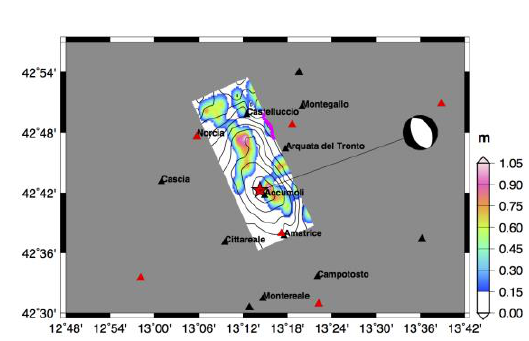
Figure 1: Inverted rupture model [Cirella& Pi- atanesi, 2016] projected on the Earth surface with villages up to 20 km distant from the nucleation . Colors on the fault plane indicate the slip distribu- tion; black contours represent the position of the propagating rupture at 1 s interval. Violet line displays the location of the observed surface breakages (provided by S. Gori & E. Falcucci- EMERGEO WG).